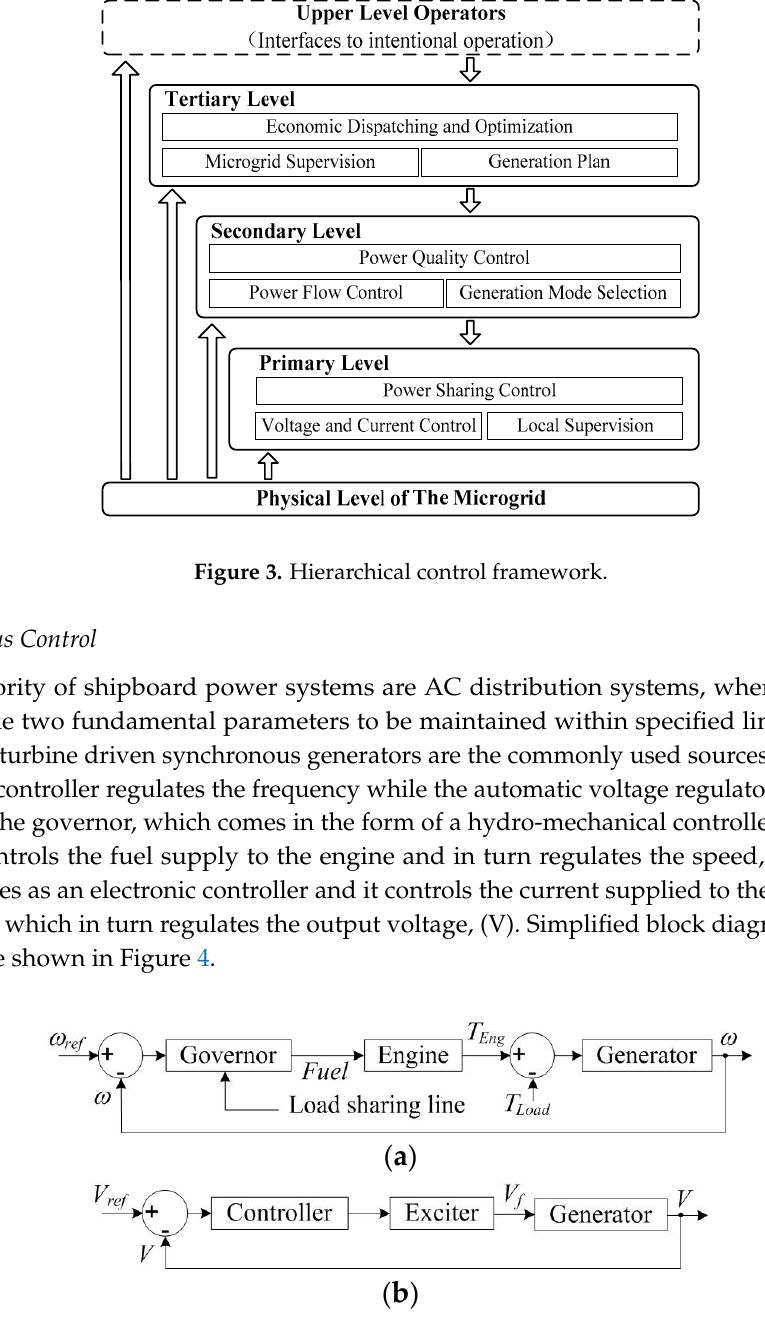
Figure 4. ( a ) Isochronous speed controller; ( b ) automatic voltage regulator.